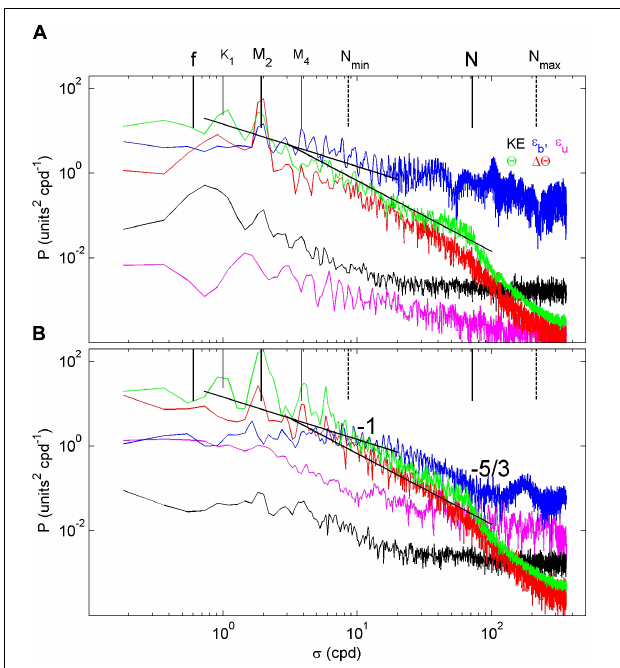
FIGURE 7 | Weakly smoothed 10 dof entire mooring period spectra of 120 s common (sub-)sampling from ADCP and T-sensor data for: Conservative Temperature at –365 m (green; average over 10 sensors between –355 and –375 m), T-difference between –325 and –405 m (red), kinetic energy (with similar form as the shear spectrum) at –335 m (black), dissipation rates averaged over lower 60 m between –427 and –487 m = 5 mab (blue) and over the upper 60 m (purple). For reference spectral slopes are indicated in black lines. (A) MN. (B) MS, with legend for spectral slopes like ‘–1’ implying P( σ ) ∝ σ − 1 .